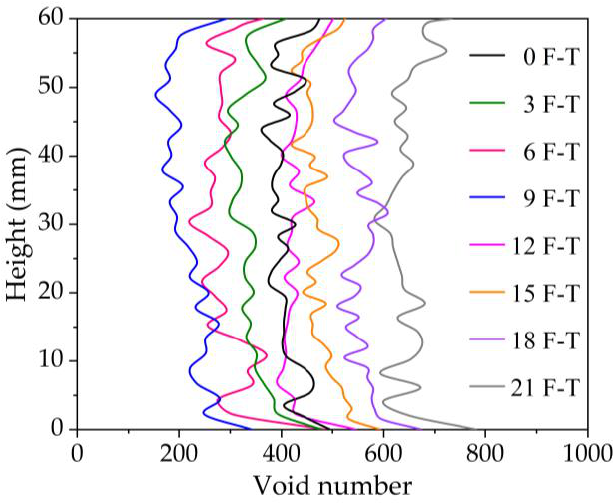
Figure 8. Distribution of the internal void number of asphalt mixture under F – T cycles.